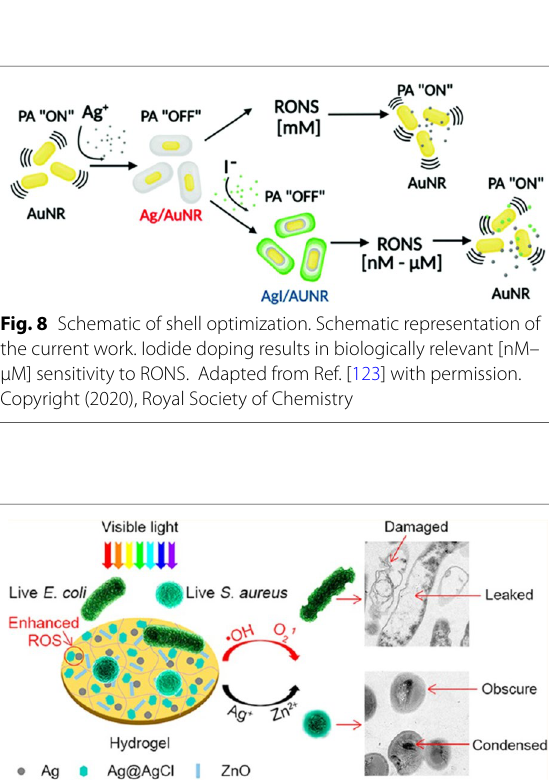
1 10 7 , 30 mL, 12 mg of catalyst). B Electrons transfer from AgBr = ×